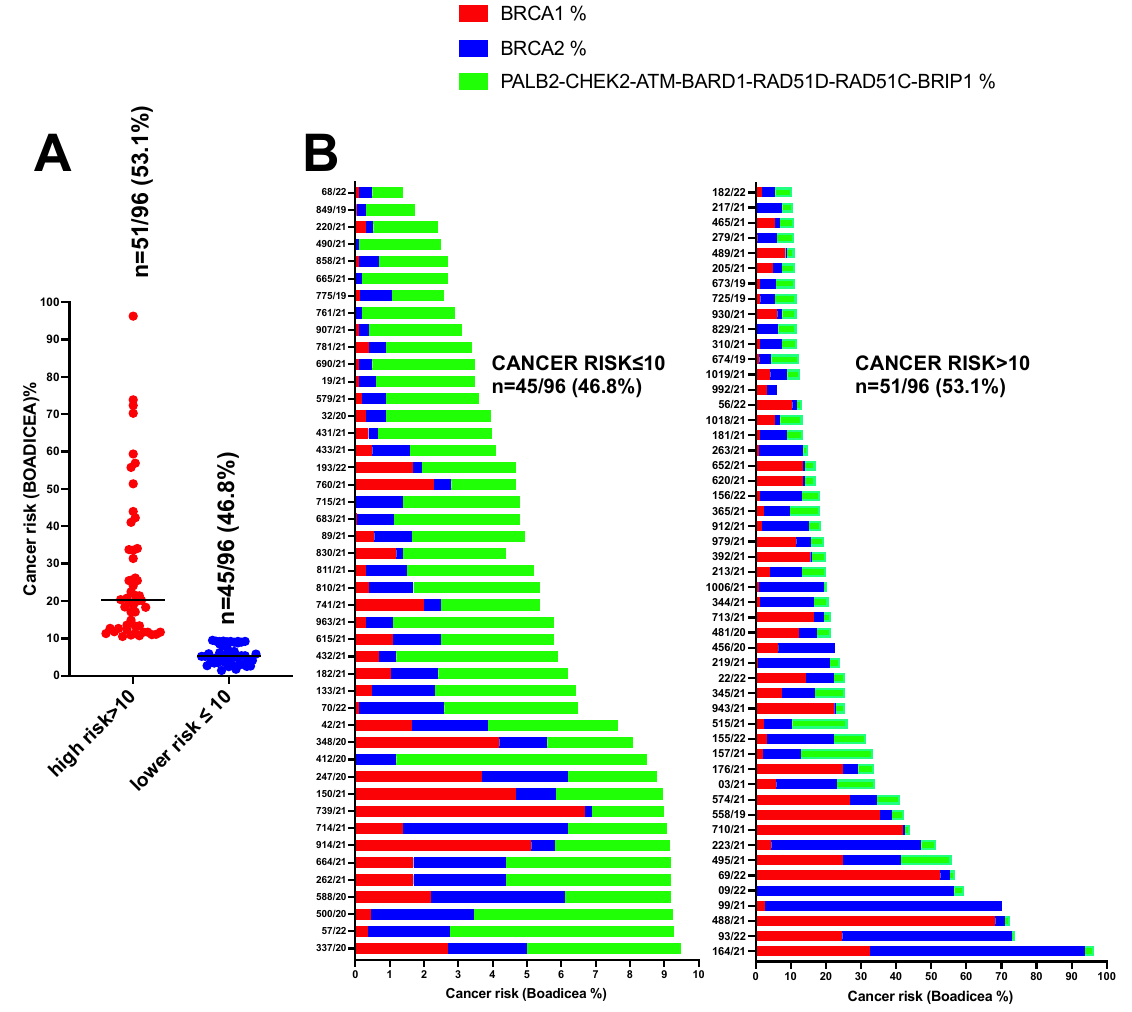
Figure 4. Likelihood of carrying PVs in the moderate-to-high-risk genes in eighty-eight BC, five OC and three PC (n = 96) patients using a 10% pretest probability threshold. ( A ) Number of patients having BOADICEA >10% and ≤10%. ( B ) Patient’s risk in the well-known high-penetrance alleles BRCA1 and BRCA2 with respect to other moderate-penetrance alleles including PALB2 , CHEK2, ATM, BARD1, RAD51D, RAD51C and BRIP1.